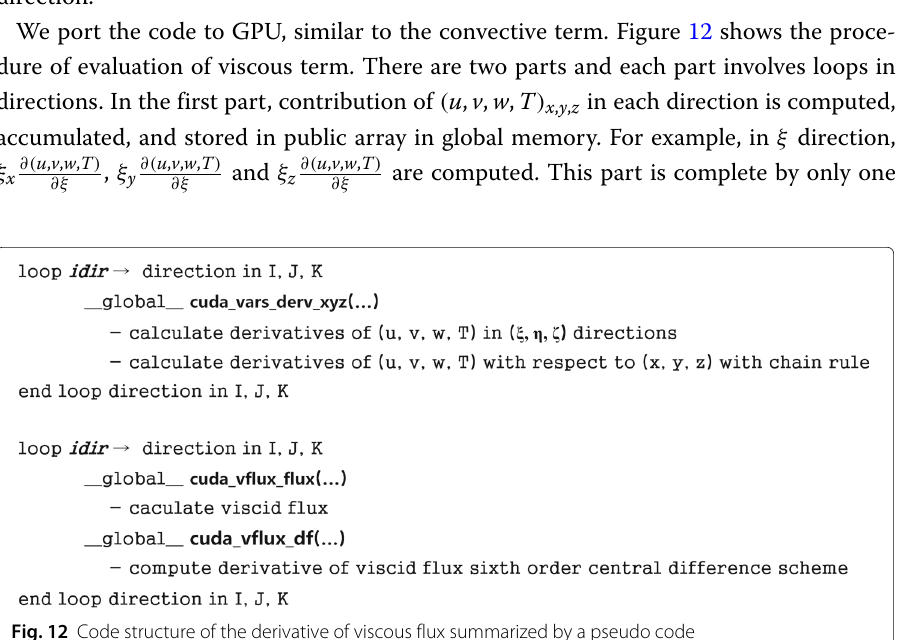
( u , v , w , T ) ξ , η , ζ can be approximated directly with sixth-order central scheme. In CPU code, the computation strategy of the viscous term is similar to the inviscid term. After ( u , v , w , T ) x , y , z are computed, viscous flux and its derivative can be obtained in each direction.